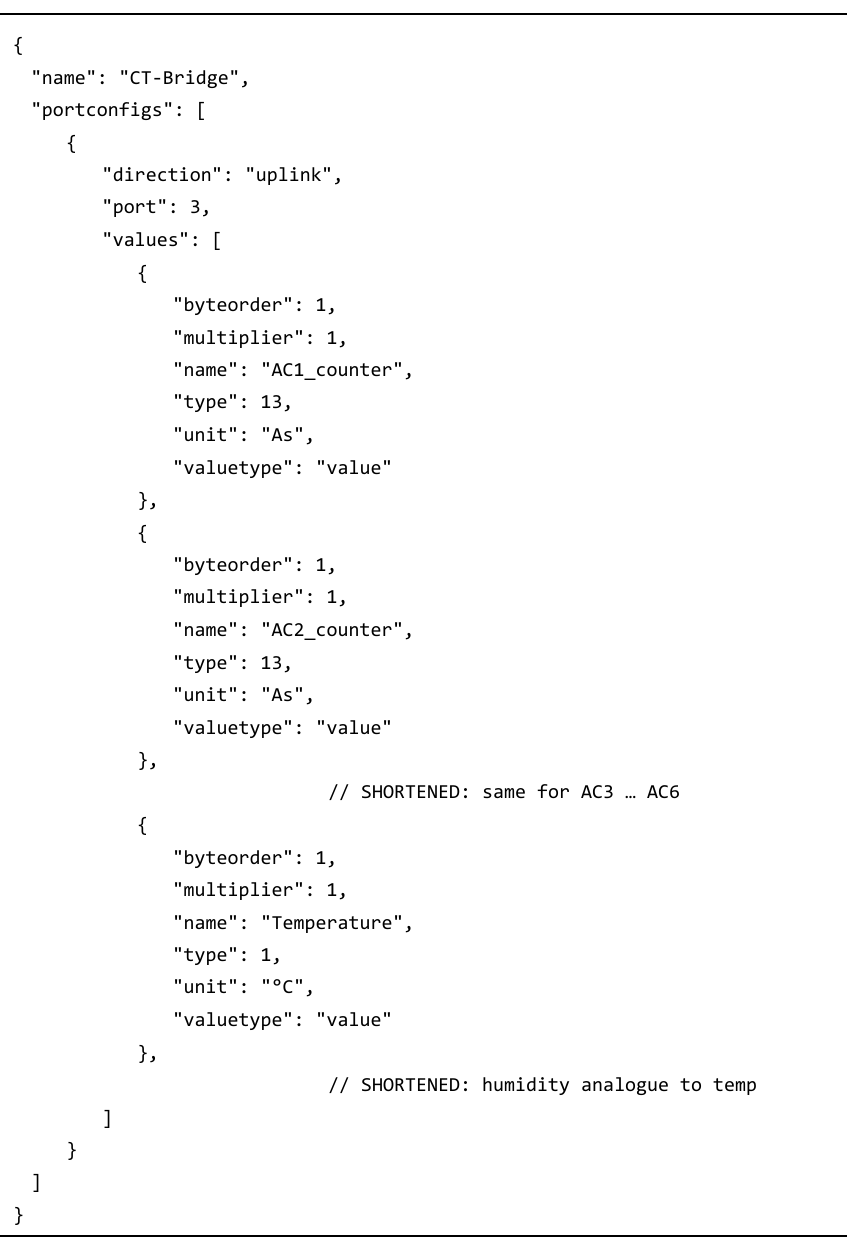
Figure 6 . LoRa payload description in JavaScript Object Notation (JSON). Figure 6. LoRa payload description in JavaScript Object Notation